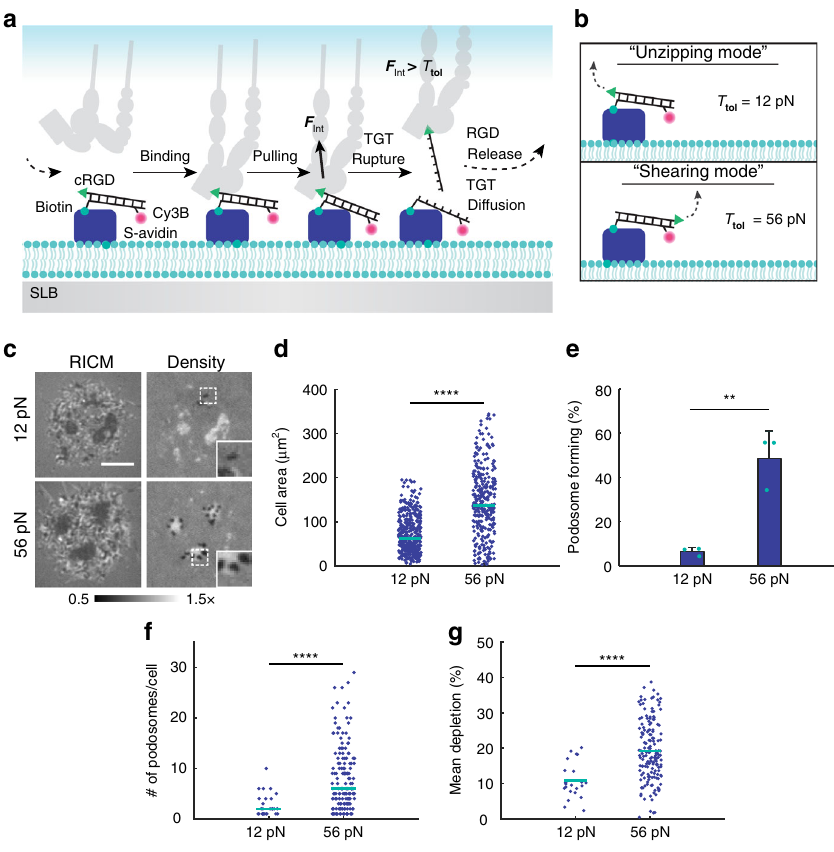
Fig. 6 Podosomes maturation requires F > 12 pN integrin tension. a Schematic depicting integrin-TGT interaction on an SLB. First, an integrin receptor binds to a TGT duplex on the SLB. Upon F Int > T tol , the TGT irreversibly ruptures, creating a transient local concentration gradient. Probe density is replenished through diffusion, and the cycle repeats. b T tol is set by relative orientation of the cRGD ligand and the biotin anchor. c Representative images of podosomes on TGTs. Scale bar, 5 μ m. d Cell area on TGTs. Teal bars represent the median area. Statistics were performed with a rank sum test. At least 332 cells were analyzed per condition, three experiments. e Percentage of cells forming podosomes on TGTs. Bars represent the mean ± s.d. (error bars), and teal circles represent individual experiments. Samples were compared using an unpaired two-tailed Student's t test. At least 76 cells were analyzed per surface, three experiments. f Scatter plot showing the number of podosomes per cell in podosome-forming cells on 12 versus 56 pN TGTs. Teal bars represent the median. Statistics were performed using a rank sum test. At least 25 cells were analyzed per condition, three experiments. Outliers more than three quartiles above or below the upper quartile were eliminated. g Scatter plot showing the mean podosome depletion on 12 versus 56 pN TGTs. Teal bars represent the mean depletion. Statistics were performed using a two-tailed unpaired Students t test. At least 25 cells were analyzed per condition, three experiments. Cells spread for 2 h on TGTs prior to imaging. ** P < 0.01, **** P < 0.0001. Source data are provided as a Source Data fi